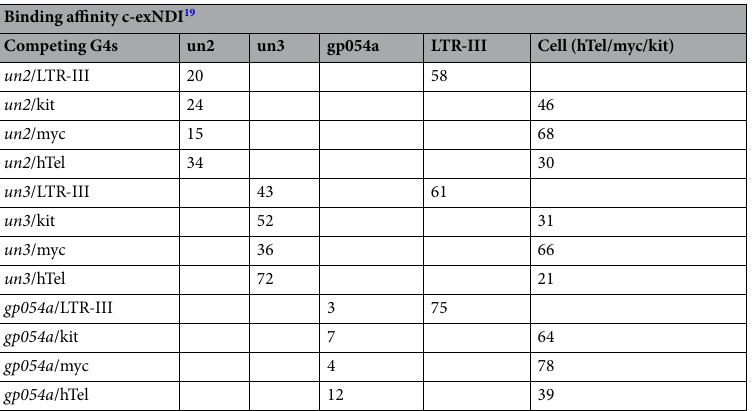
Table 2. Relative binding affinity, analyzed by MS competition assay for un2 , un3 , gp054a , hTel21, c-kit2 (kit), c-myc (myc) and HIV-1 LTR-III G4-folded